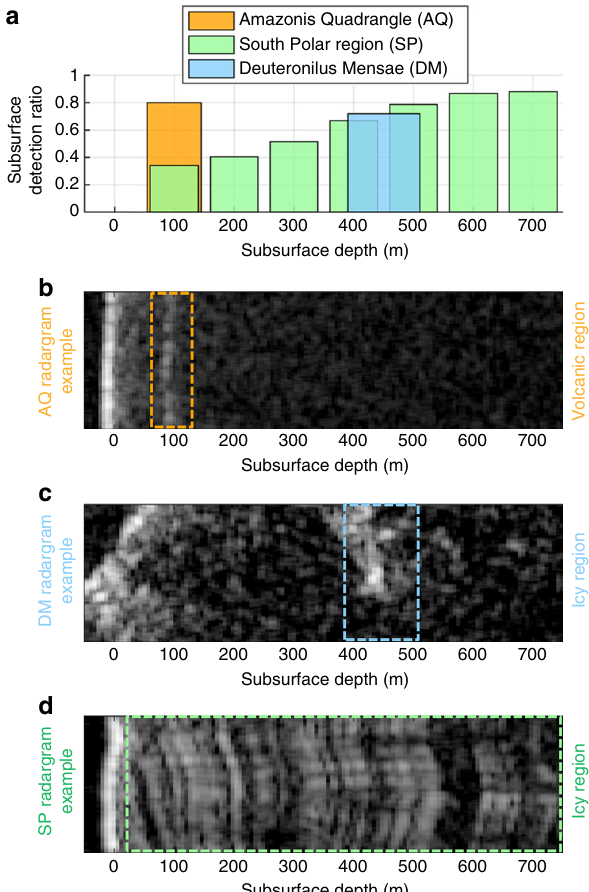
Fig. 8 Experimental results on subsurface detection ratio (signal-only hypothesis) for the different data sets and AQ, DM, and SP regions radargrams examples. a Subsurface detection ratio, de fi ned as the number of subsurface features correctly classi fi ed as subsurface versus the total number of detected features, at each given subsurface depth. The plot highlights the difference in subsurface detection ratio performance between a volcanic and an icy region due to the different subsurface attenuation values. b Typical radargram for the AQ region. The subsurface stratigraphy is such that the features are clustered around an average equivalent depths of 100 m. c Typical radargram for the DM region. The subsurface features are clustered around an average equivalent depth of 450 m. d Typical radargram for the SP region. The typical subsurface layering structure of this region allows the computation of statistics to be performed from 50